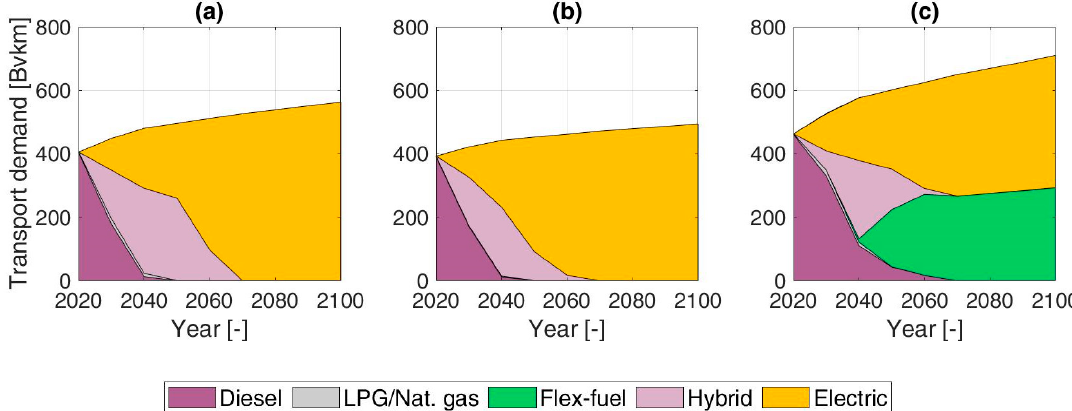
Figure 9. Heavy-duty vehicle (HDV) fleet composition in the three analyzed storylines: A ( a ), B ( b ) and C ( c) .